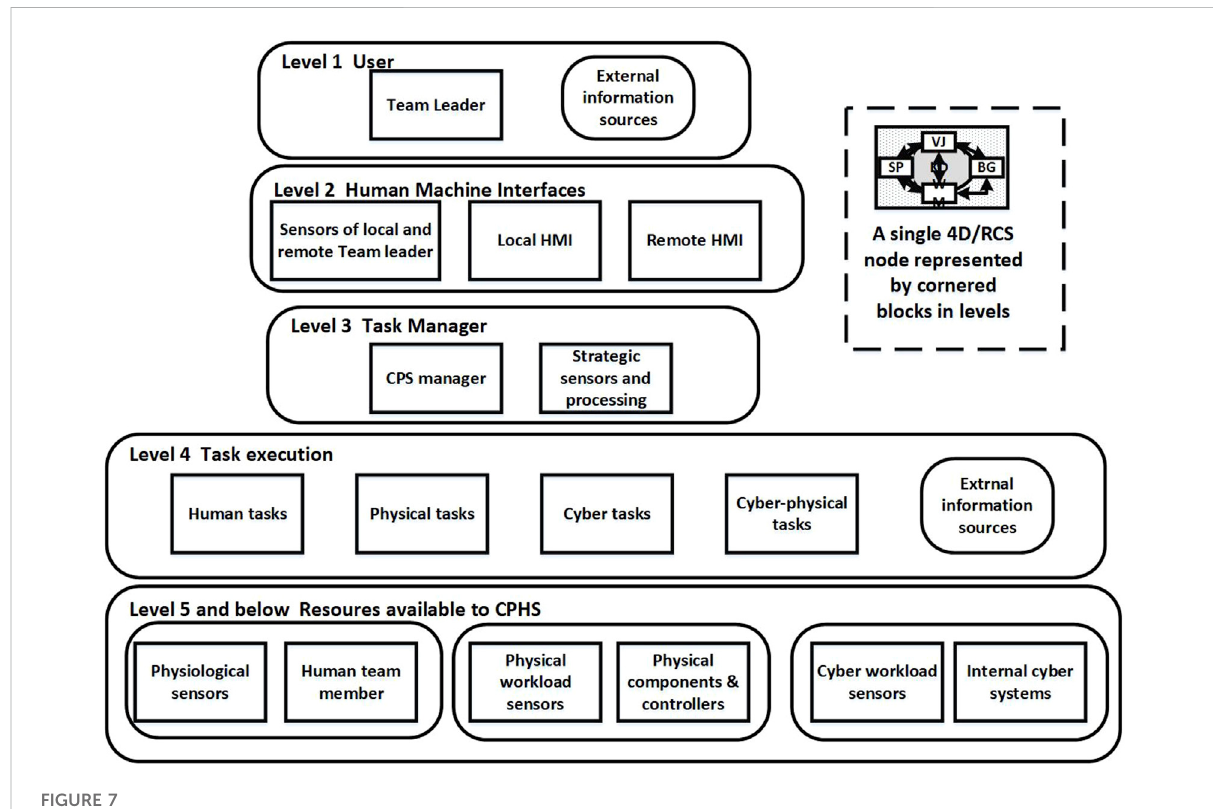
FIGURE 7 A planetary rover as an A-HMT-S showing the two Team